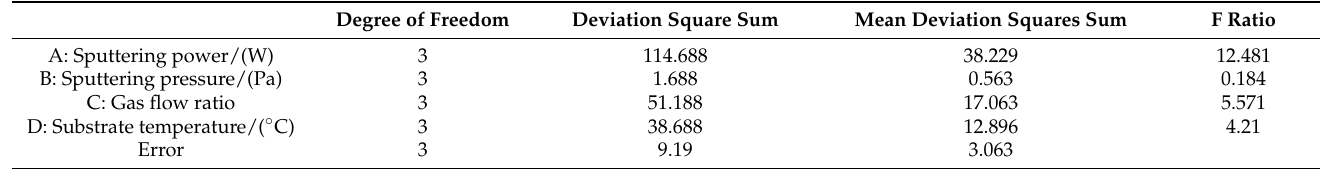
Table 10. Variance analysis of film surface roughness Ra test results of Si 3 N 4 film. Degree of Freedom